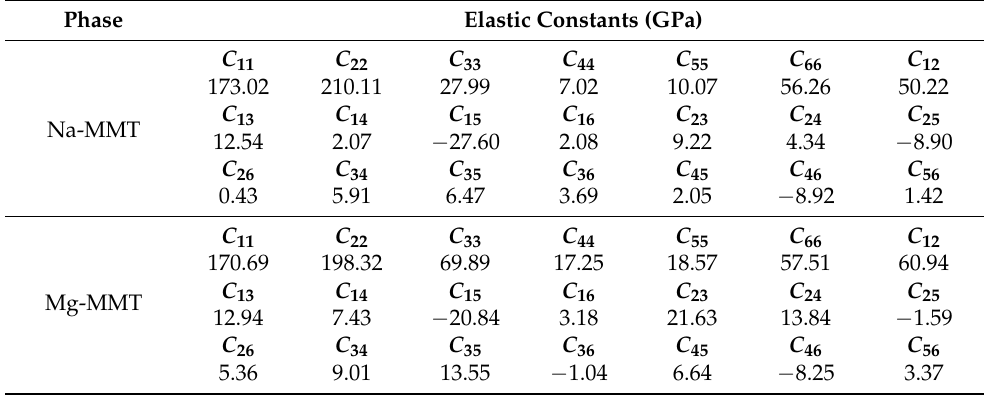
Table 6. The calculated elastic constants C ij of the Na-MMT and Mg-MMT at 0